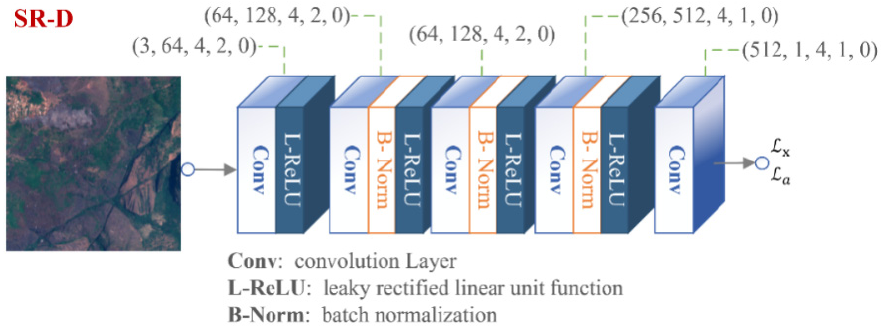
Figure 8. Structure of the super-resolution discriminator